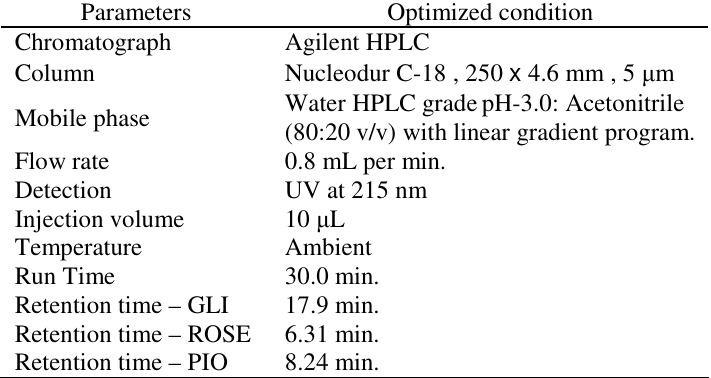
Table 1. Optimization of experimental conditions